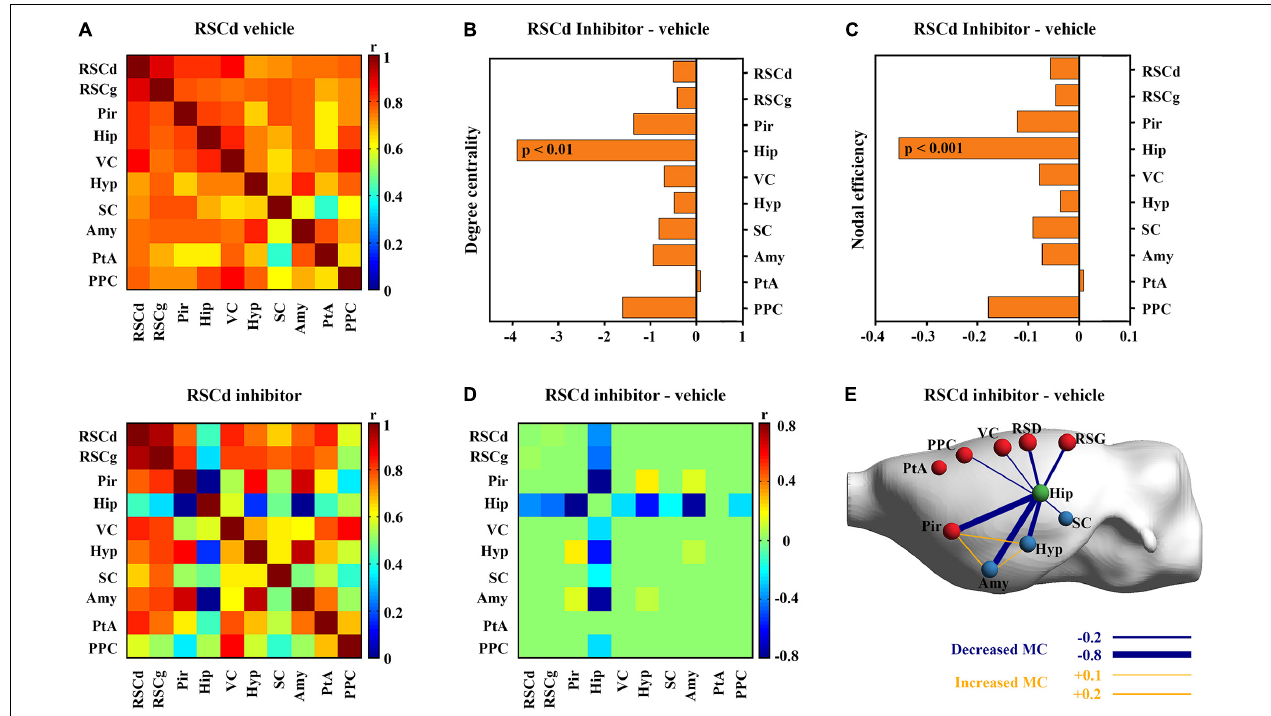
FIGURE 4 | Effects of suppressed RSCd on its core metabolic networks during CFC. (A) Core metabolic network of RSCd vehicle group and inhibitor groups during CFC. (B) Degree centrality and (C) nodal efficiency of the hippocampus significantly decrease in rats with suppressed RSCd. (D) 10,000 permutation tests reveal a significant decrease in metabolic correlations between the hippocampus and multiple nodes in rats with suppressed RSCd. (E) The links that changed significantly in metabolic connectivity between nodes of rat brain with suppressed RSCd. MC, metabolic connectivity. RSCd vehicle group n = 24, RSCd inhibitor group n = 22. p < 0.05 was considered statistically